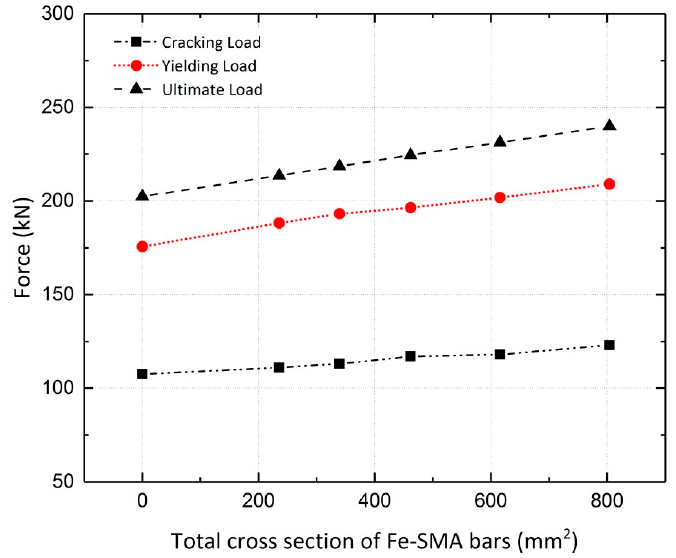
Figure 31. Effect of non-activated Fe-SMA bars on cracking, yielding and ultimate loads of girders.